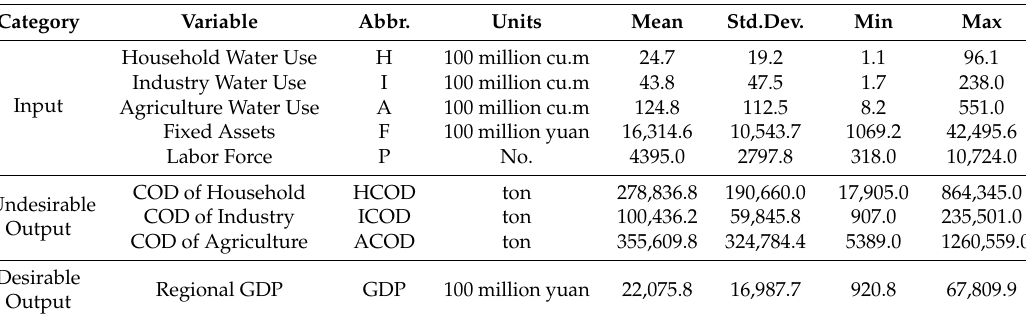
Table 2. Summary of input and output indicators.